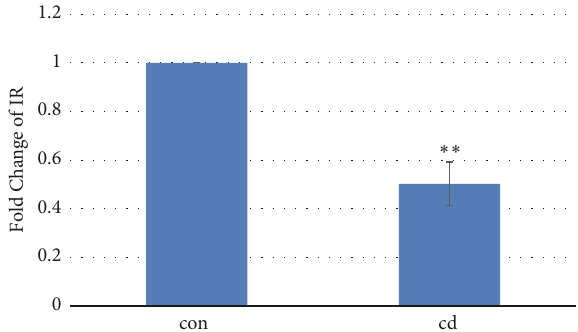
Figure 6: Effects of Cd (cadmium chloride; 1 mg/kg, intraperitoneal injection, twice weekly) on mRNA levels of IR in mouse liver, n=5/group. ∗∗ Significantly different from con and Cd groups, at P <